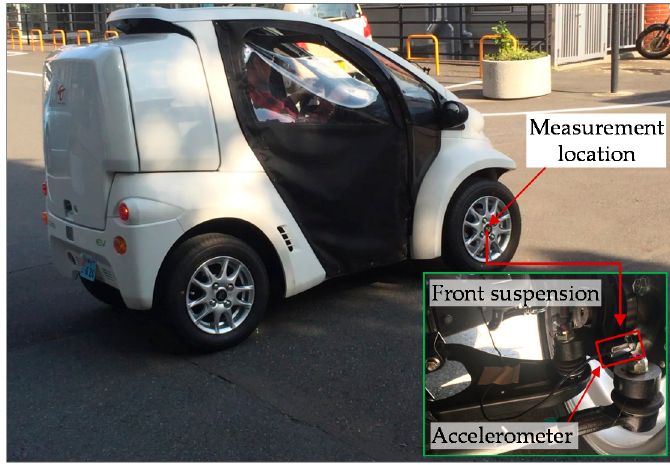
Figure 7. Paved road testing and on-road noise measurement on front-wheel suspension.